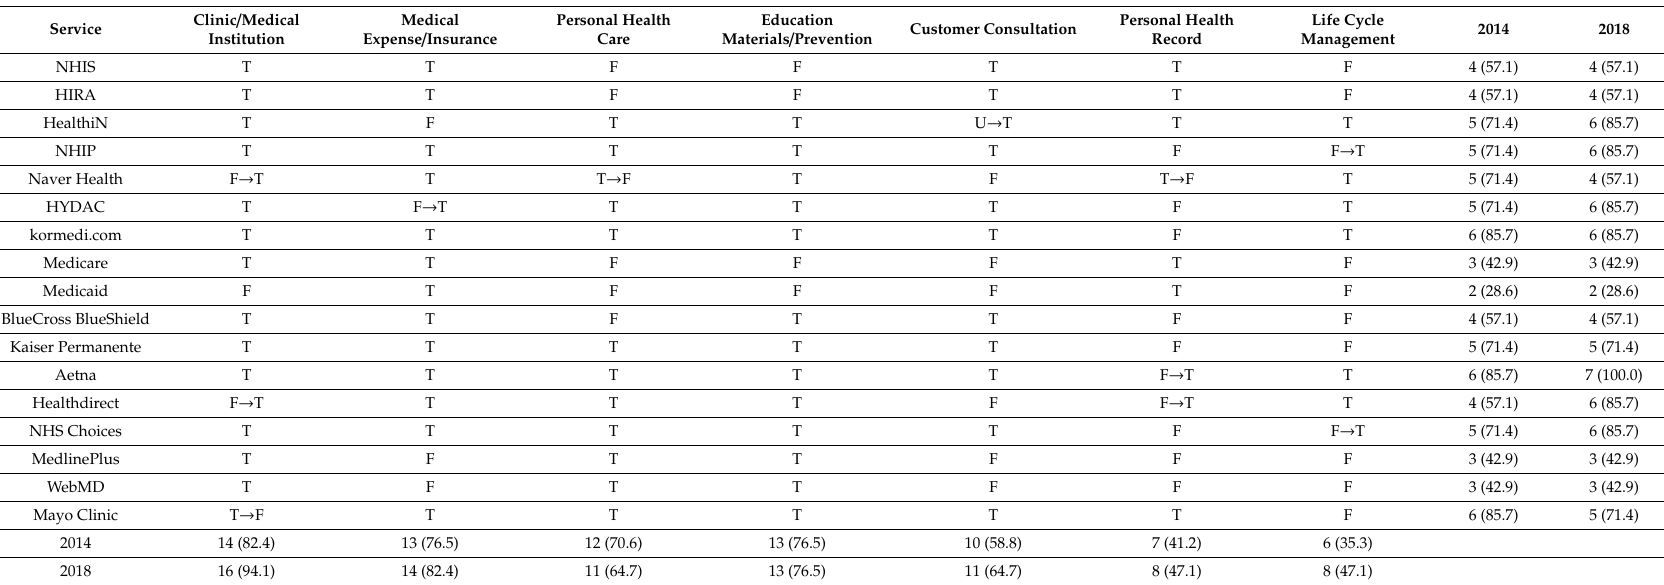
Table 5. Changes in the content scope on health information portals 2 (frequency,